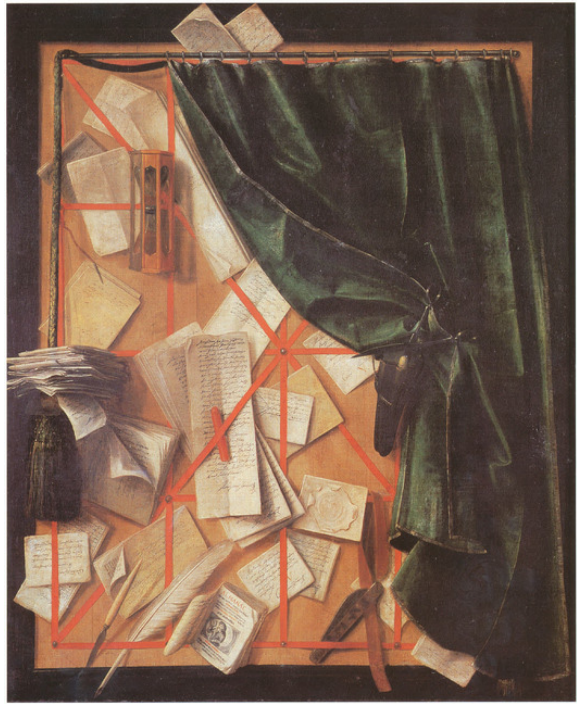
Figure 2. Trompe l’oeil of a quodlibet with hourglass, razor, scissors and curtain (Gijsbrechts